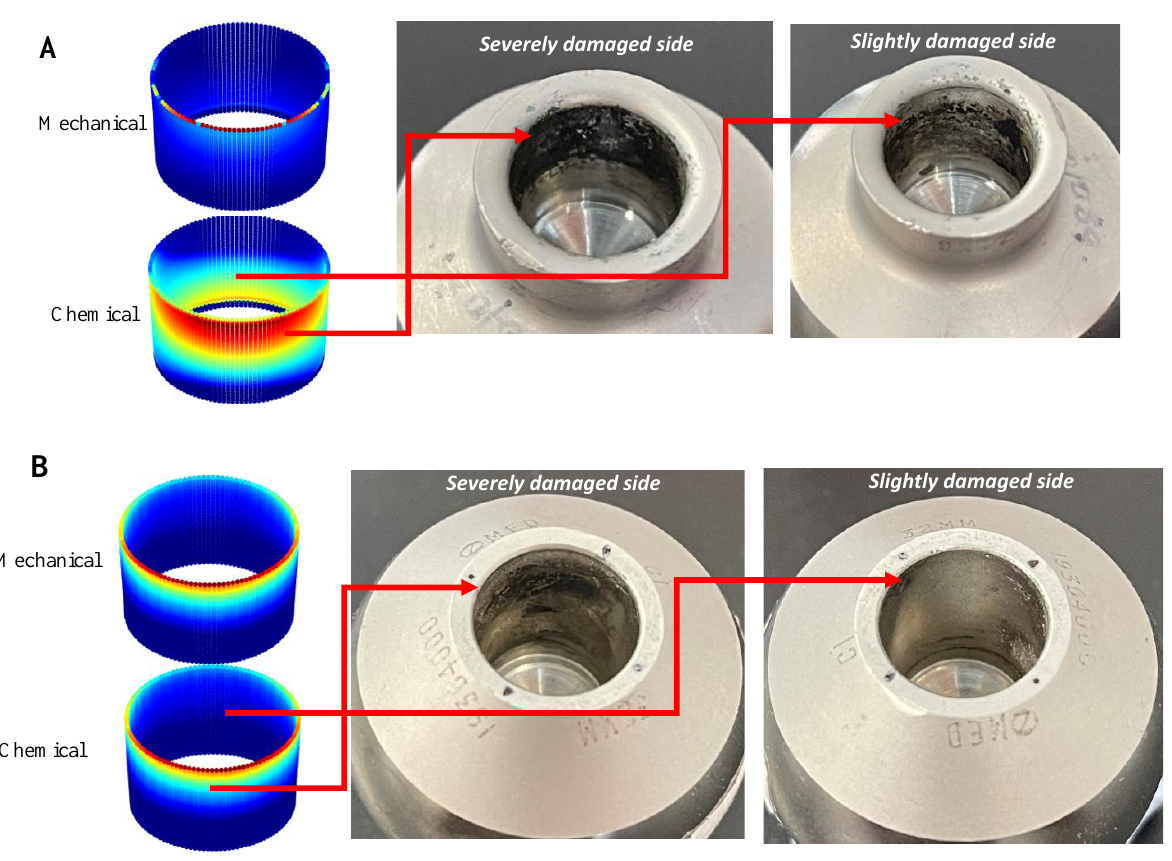
Figure 10. The figure shows comparison between the tribocorrosive wear profiles on the head tapers between FE model and retrieved samples with different levels of assembly force: ( A ) less than/equal to 2 kN, ( B ) more than/equal to 4 kN.